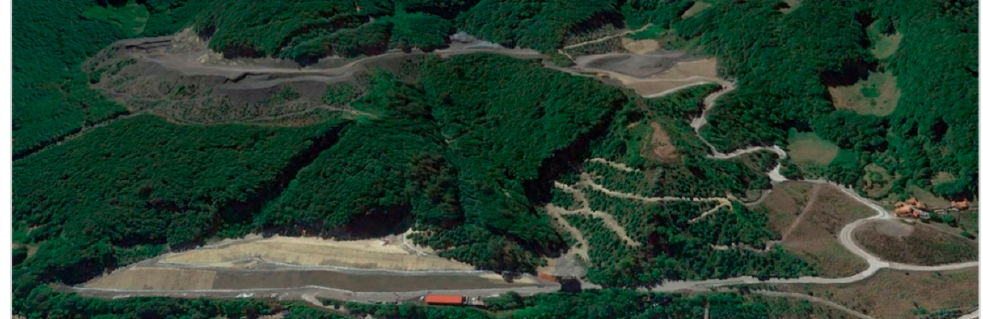
Figure 1. Figaredo mine and waste heaps.